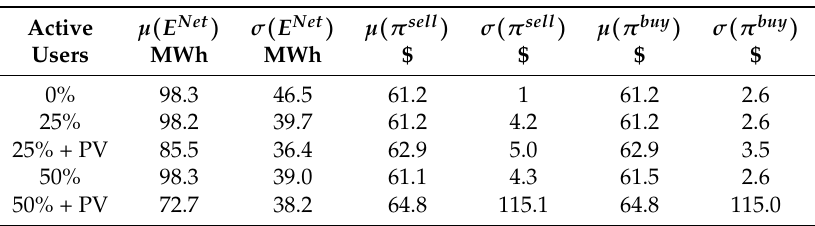
Table 3. Summary of numerical